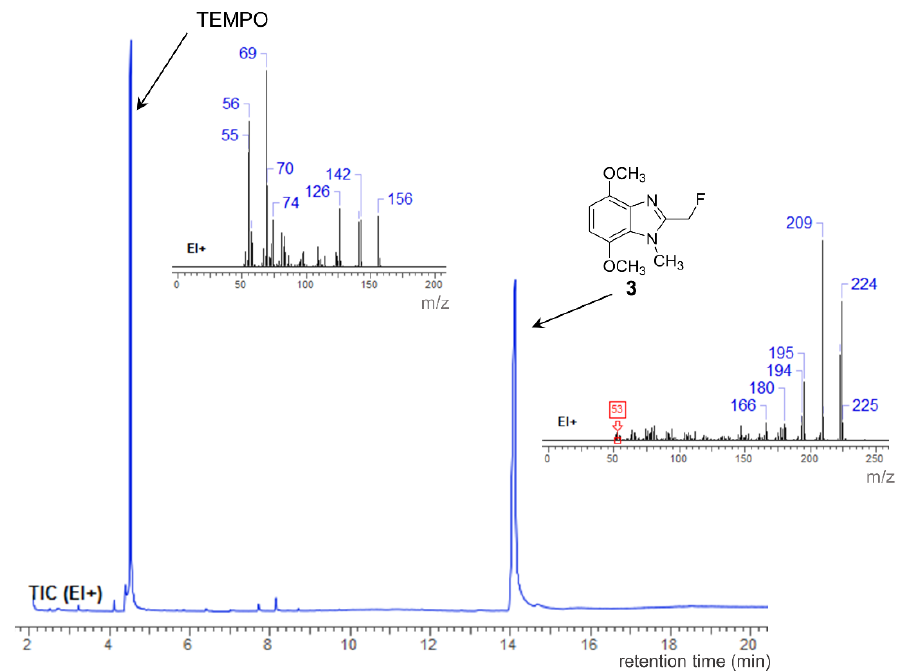
Figure 2. GC-MS analysis of the reaction mixture for the fluorination of alkoxyamine 1 .